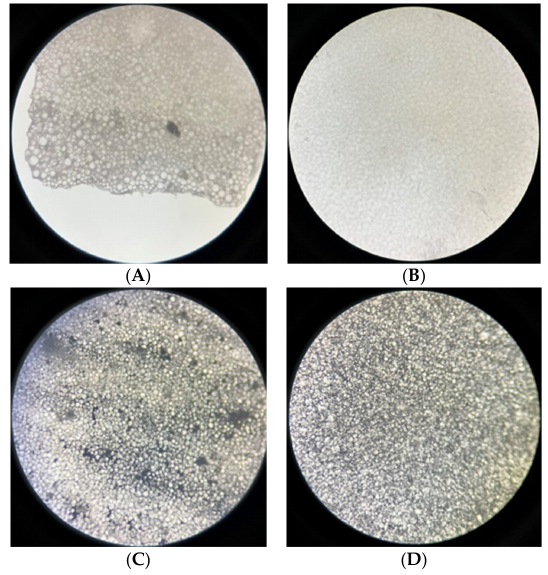
Figure 10. Stereo microscope photos of PMMA-MgO nanocomposite disc (( A ) non-ethanol-assisted and ( B ) ethanol-assisted) and PMMA-Ag nanocomposite disc (( C ) non-ethanol-assisted and ( D ) ethanol-assisted).